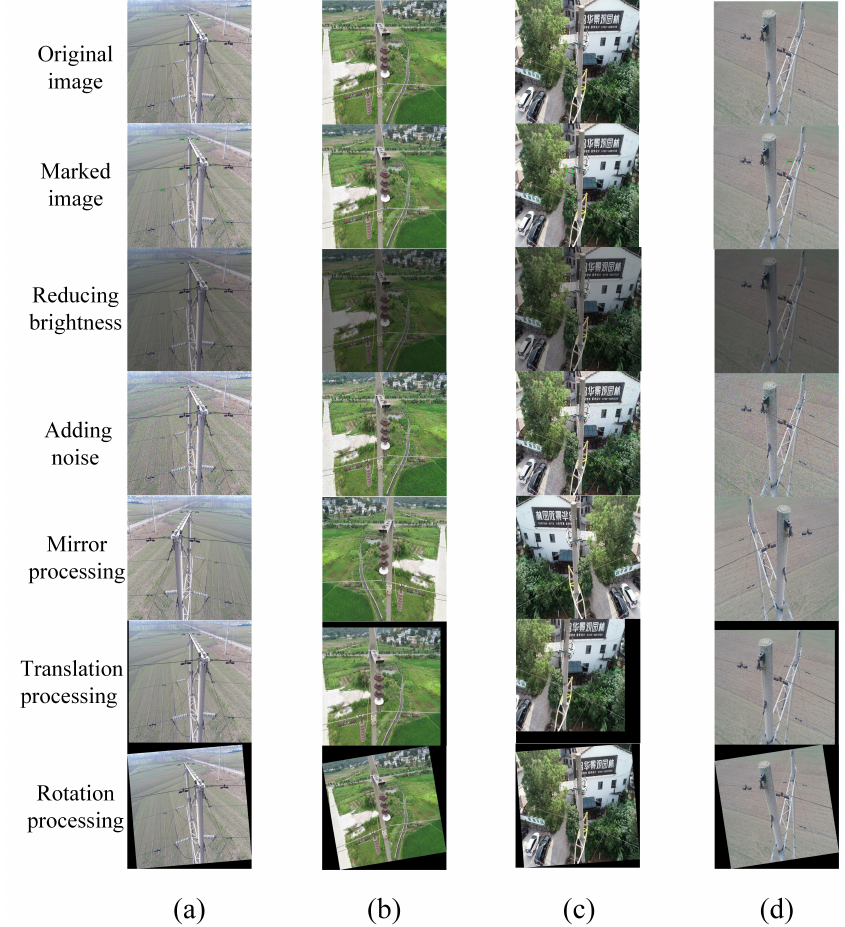
Figure 11. UAV images of transmission line fittings after data enhancement. The columns ( a – d ) are the four examples to show the effect of data